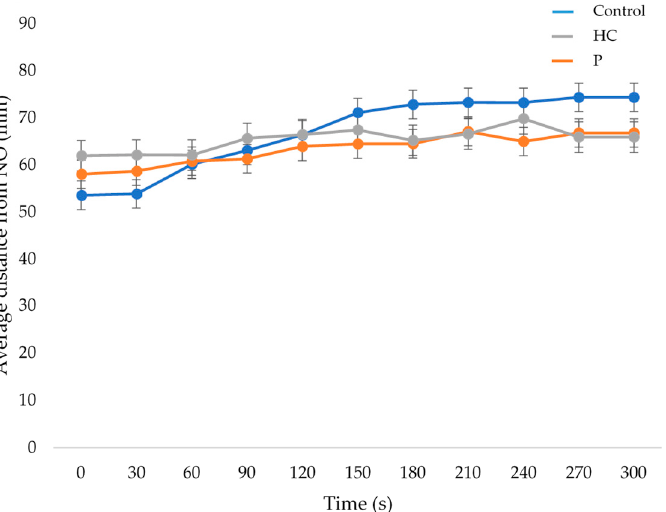
Figure 6. Average distance ( ± SEM) from a novel object (traffic cone) of a pair of birds every 30 s after they were placed in a test arena at 22 days of age. Birds were raised under standard conditions (control, blue line); with additional physical items (P, grey line); or with additional human contact (HC, orange line). Results are presented for birds that were tested at 21 days of age.